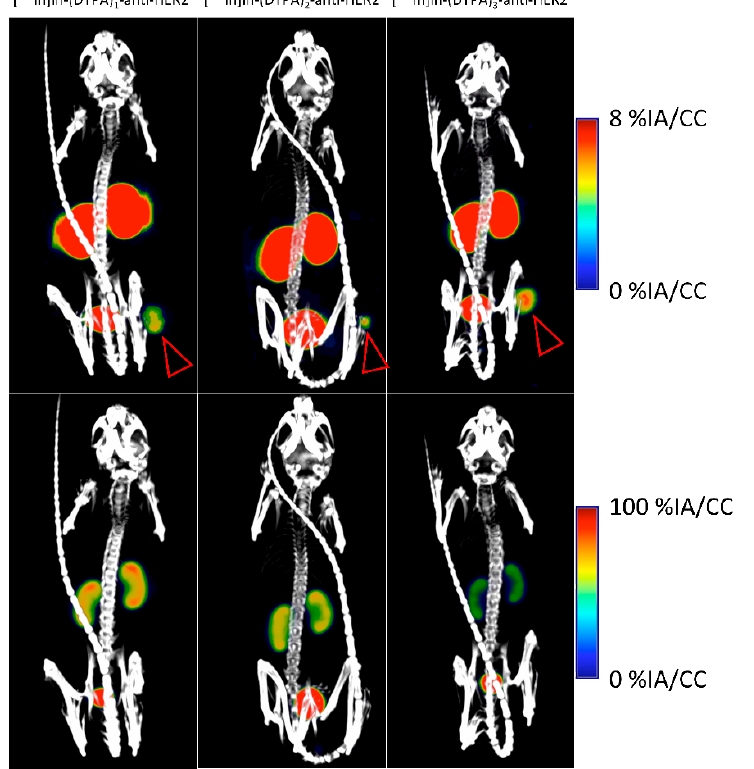
Figure 5. SPECT/CT imaging of different [ 111 In]In-(DTPA) n -anti-HER2 fractions 1 h p.i. in SKOV3 tumor-bearing athymic nude mice. Scaling was adjusted depending on the tracer uptake values of the organ in focus. The ( upper panels ) are focused on the tumor (denoted by a red arrow). The ( lower panels ) are focused on the kidneys, which show a decrease in signal with increasing chelator substitution.